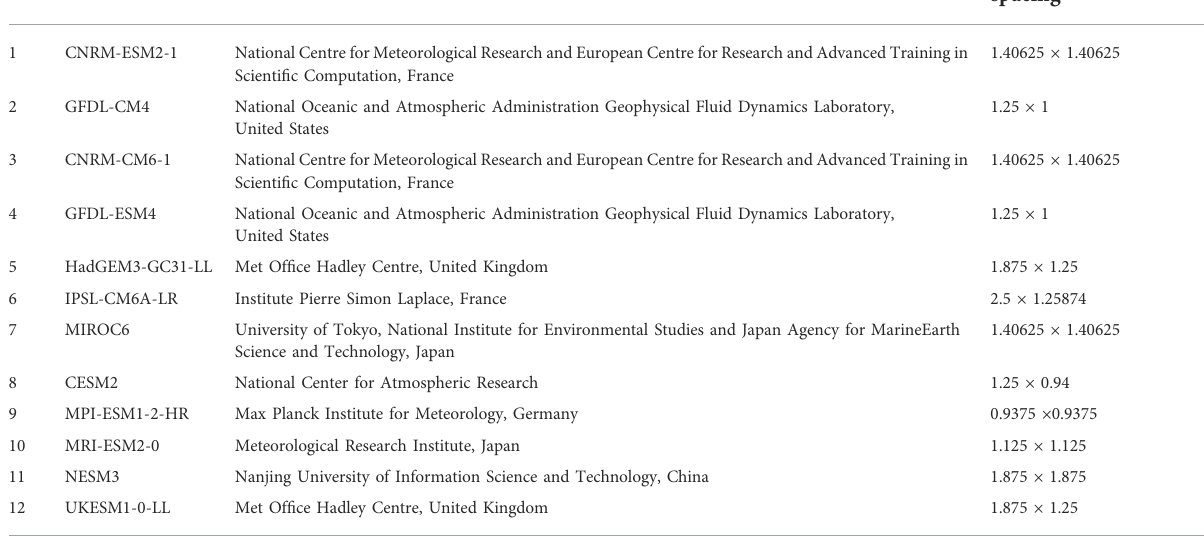
TABLE 1 Details of the CMIP6 GCMs used in this